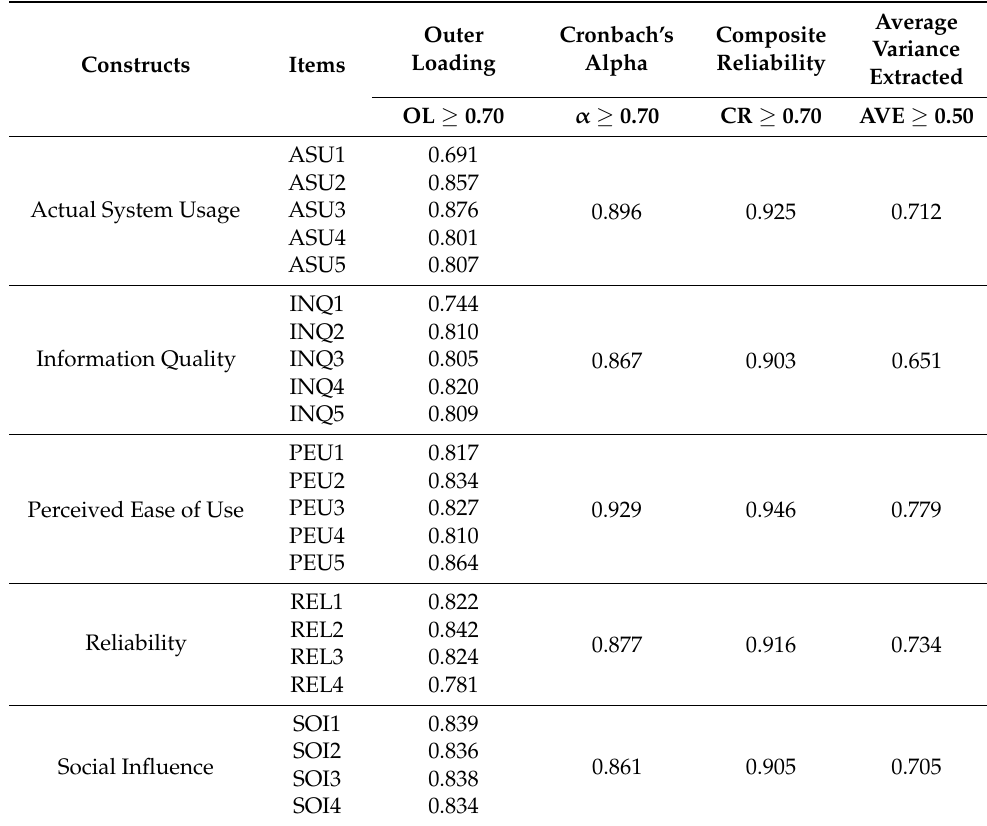
Table 2. Factor analysis (OU), reliability ( α ), composite reliability (CR) and average variance ex- tracted (AVE).